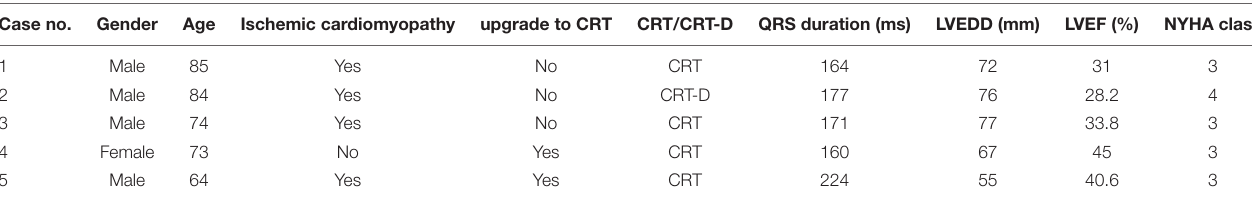
TABLE 2 | Procedural details.